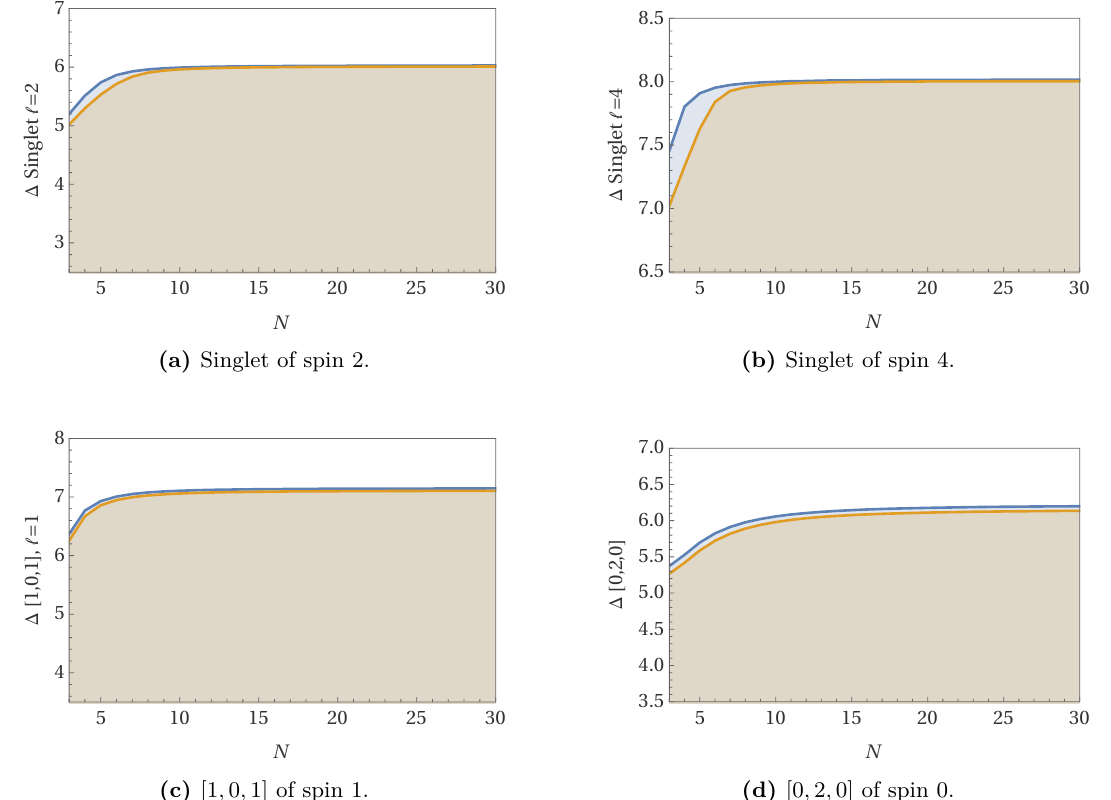
Figure 6. Bounds on the gap of the lightest operator for other representations of spin and R- symmetry with the mixed correlator. In order from the top left we have a singlet of spin 2 , spin 4 , a [1 , 0 , 1] of spin 1 and a [0 , 2 , 0] of spin 0 .